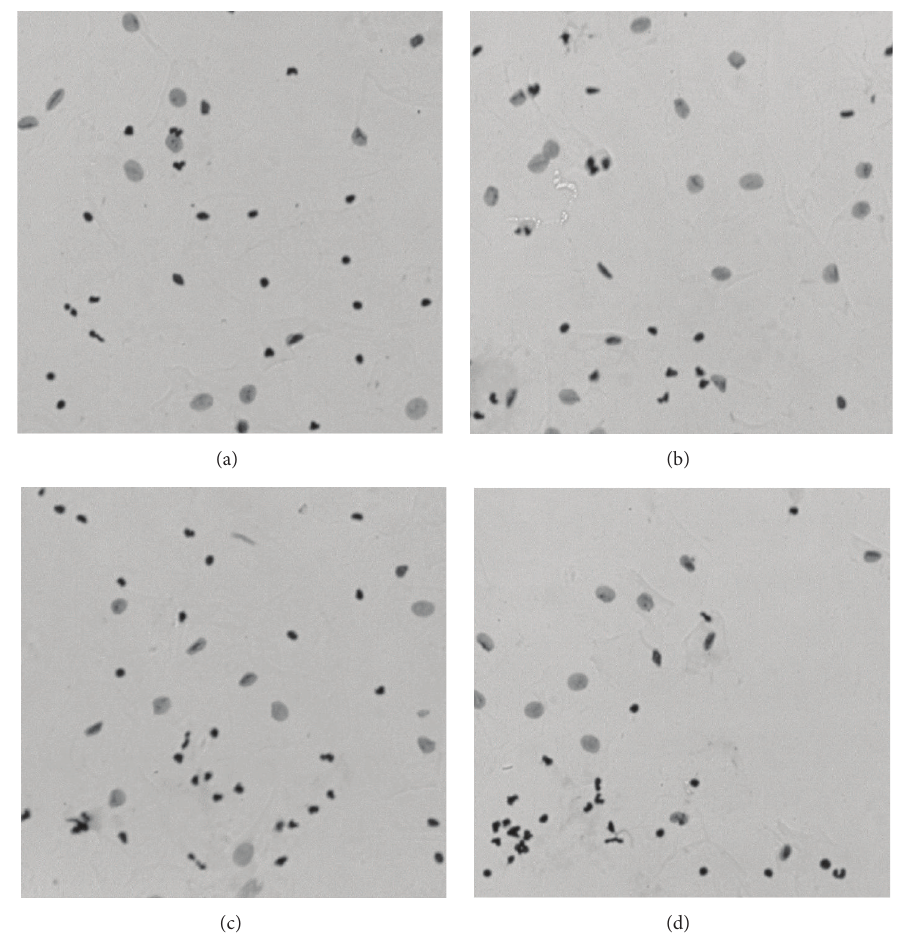
Figure 2: The nuclei after thin liquid based cytology. (a) Sample image 1. (b) Sample image 2. (c) Sample image 3. (d) Sample image